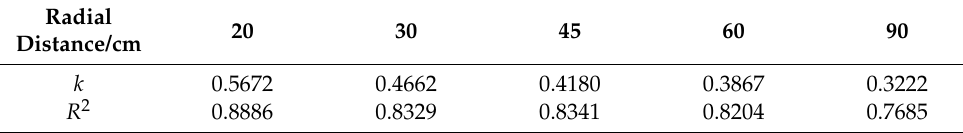
Table 3. Adjustment factors for deflection